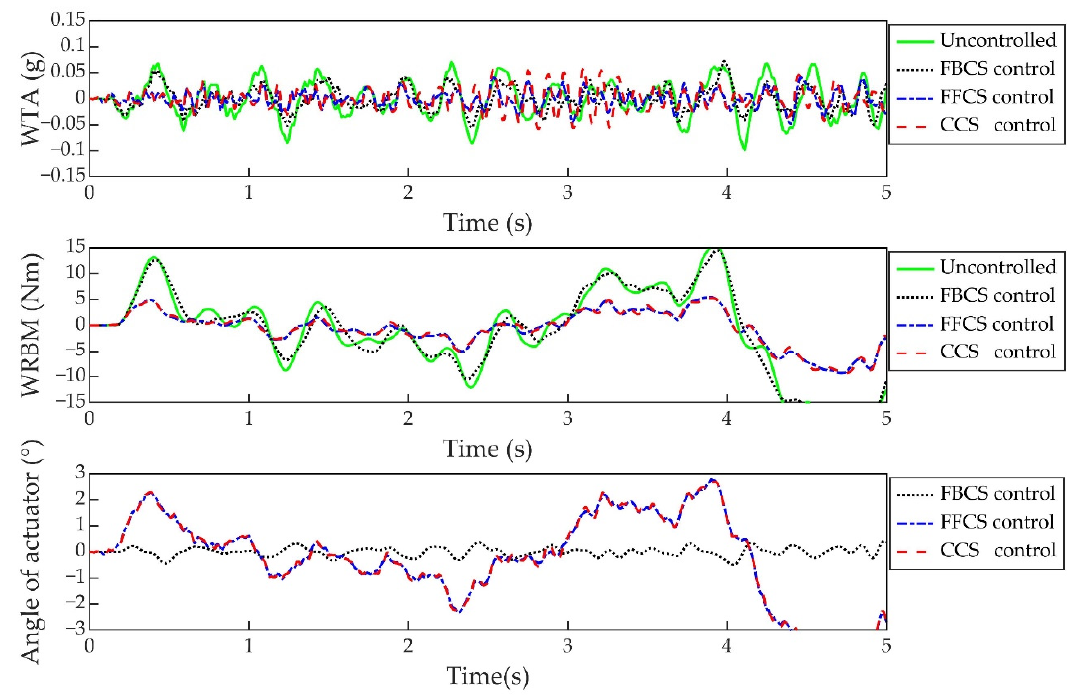
Figure 11. Comparison of gust alleviation effects of Dryden turbulence.